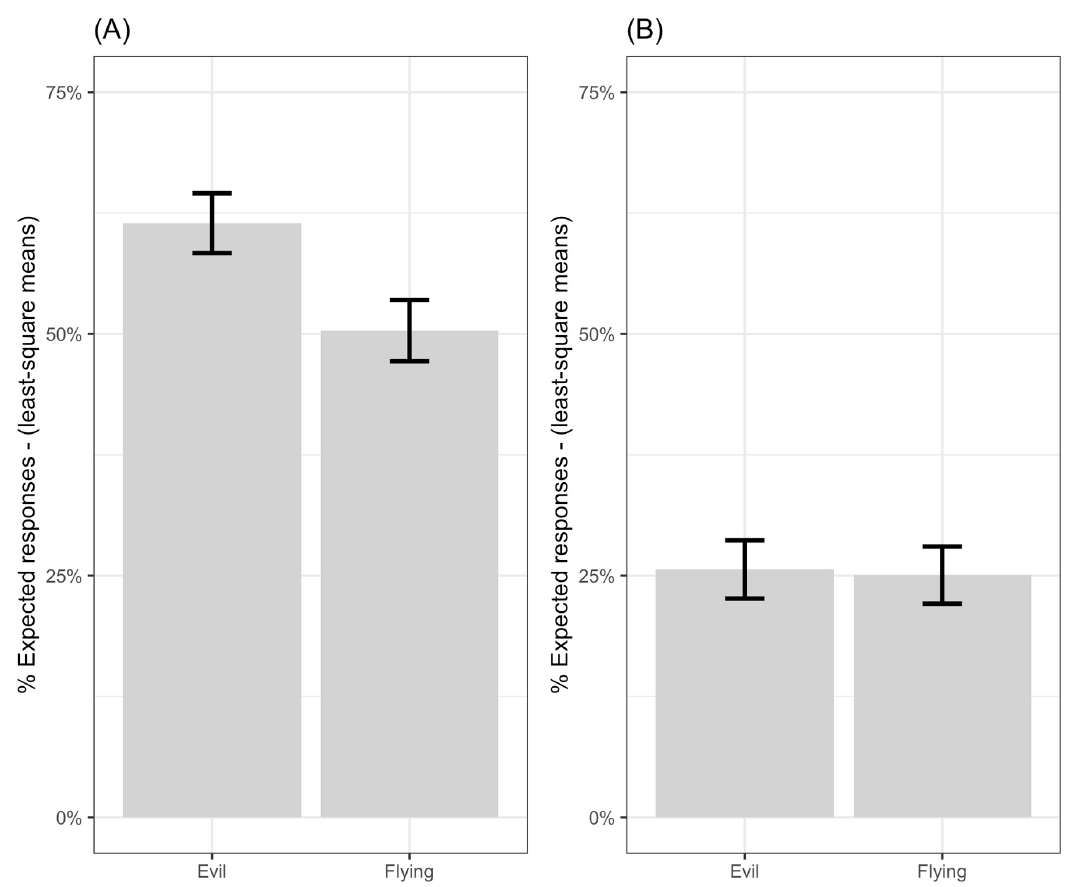
Figure 2: Estimated rate of names containing voiced obstruents (A) or sibilants (B); error bars represent standard